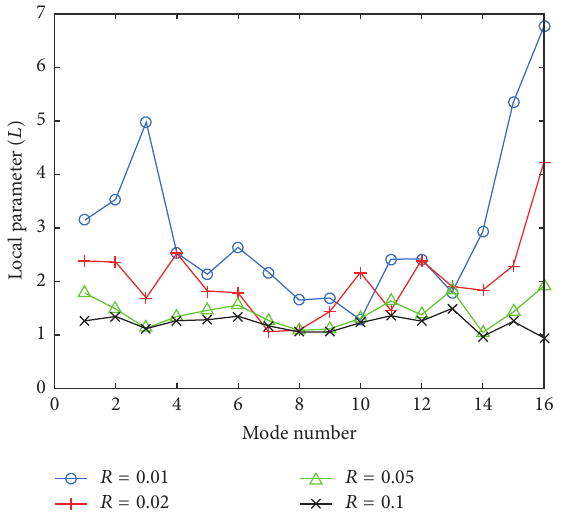
Figure 9: MLPs of MRBs under different 𝑅 .